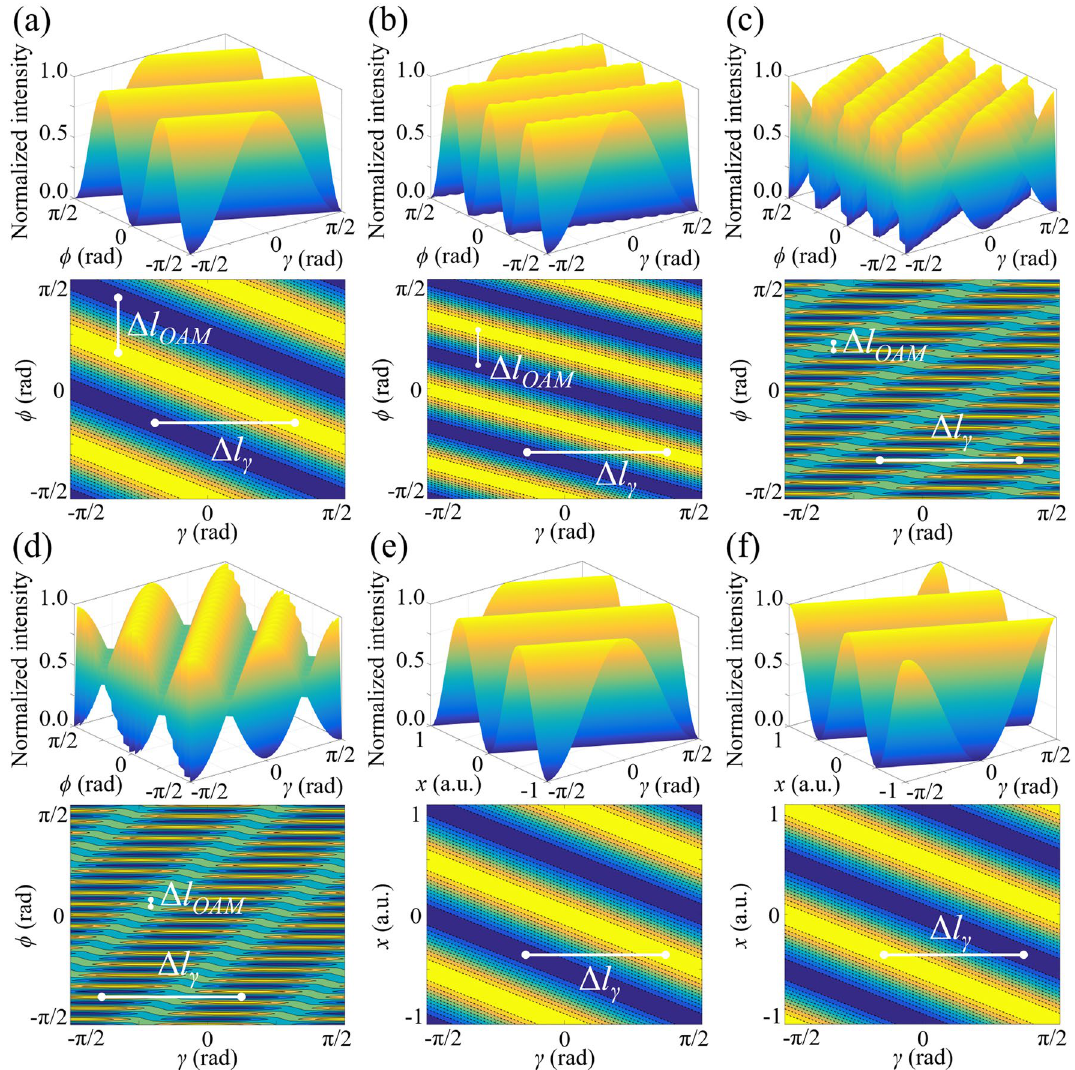
Figure 3. Dependence of light intensities on the azimuthal angle and polarization direction when the topological charges are ( a ) m = 2, ( b ) m = 3, ( c ) m = 18 and ( d ) m = 19. As the topological charges change from ( e ) even numbers to ( f ) odd numbers, the light intensity along x -axis is reversed because of a further π phase shift. The lengths of Δ l γ keep constant in ( a – f